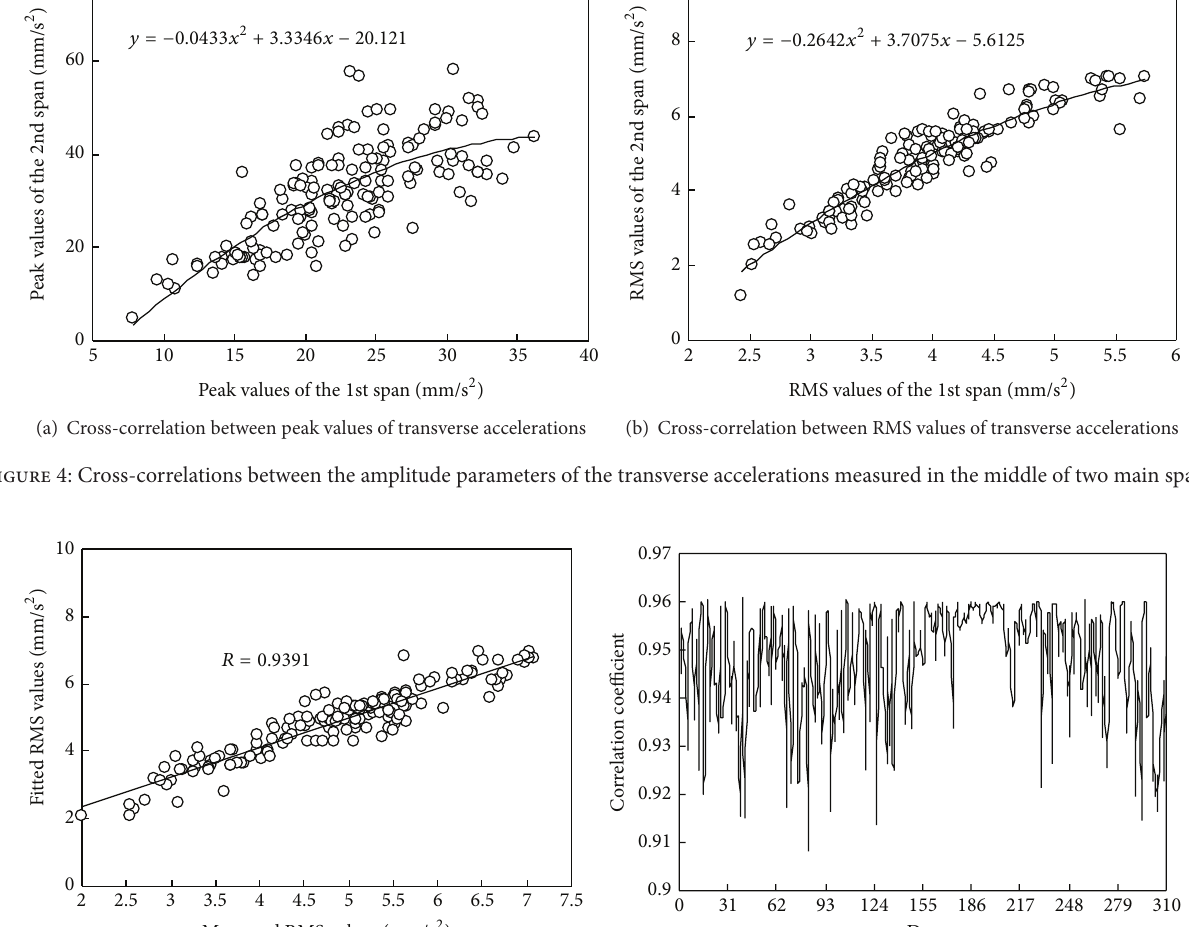
(b) Computed correlation coefficients of the 310 days in 2013